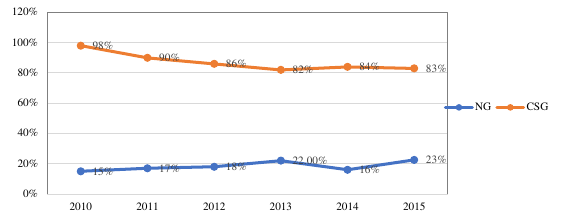
Fig. 1 Fixed assets investments of CSG and NG